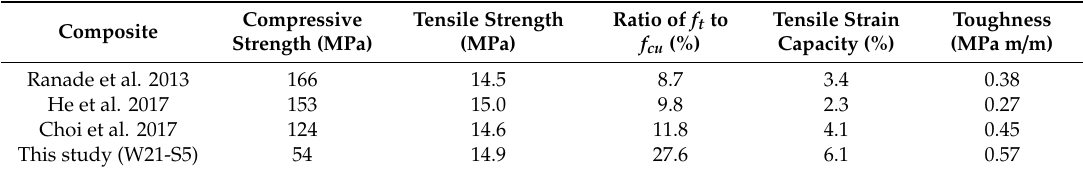
Table 3. Comparison of performance of ultra-high performance concretes with high-ductility and the W21-S5